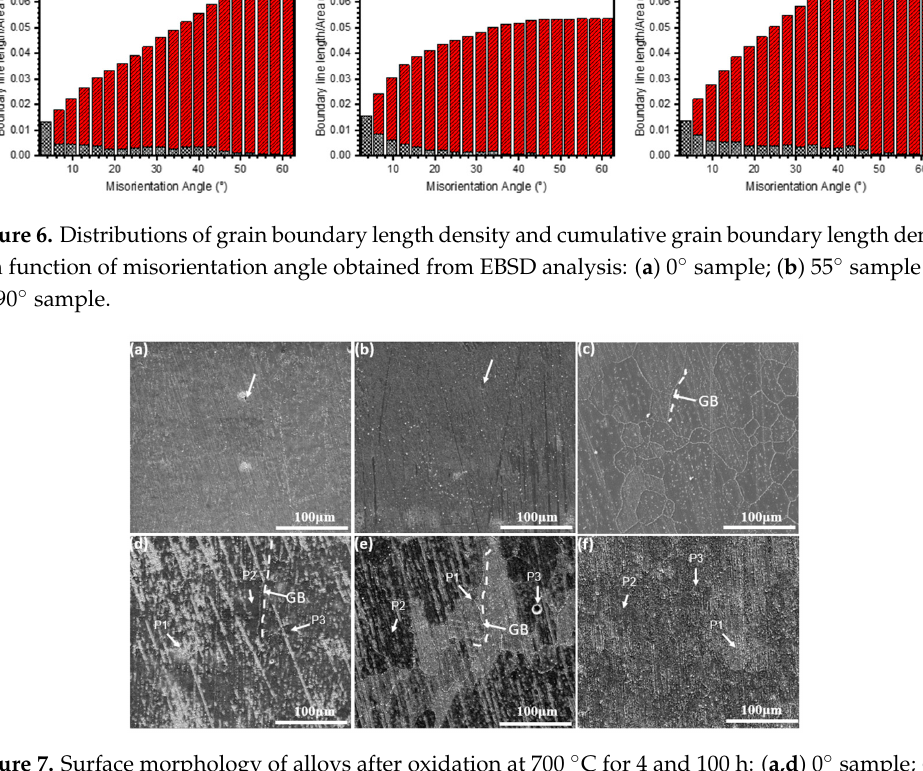
Figure 7. Surface morphology of alloys after oxidation at 700 °C for 4 and 100 h: ( a,d ) 0 ° sample; ( b,e ) 55 ° sample; ( c,f ) 90 ° sample.